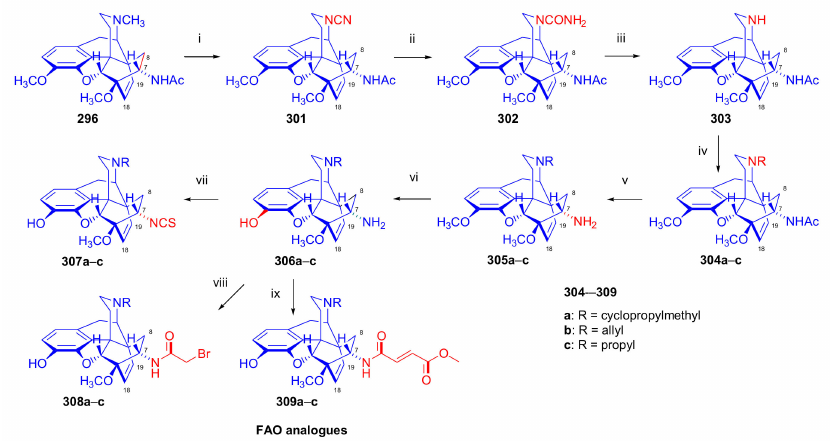
Figure 81. Synthesis of N 17 -substituted-7 α -acylamino-6,14-ethenomorphinan derivatives. Reagents and conditions : (i): BrCN, CHCl 3 , 16 h, reflux; (ii): 1M HCl, 90 ◦ C; (iii): NaNO 2 , 1M HCl, 4 h, 0 ◦ C; (iv): RBr, Na 2 CO 3 , EtOH, 16–30 h, reflux or NaHCO 3 , DMF, 85 ◦ C, 4 h; (v): 3M HCl, 110–115 ◦ C; (vi): BBr 3 , CHCl 3 ; (vii): 1.1 equiv. thiophosgene, NaHCO 3 , CHCl 3 , H 2 O, 20 min; (viii): bromoacetyl chloride, NaHCO 3 , CHCl 3 , H 2 O, 20 min; and (ix): methylfumaroyl chloride, NaHCO 3 , CHCl 3 , H 2 O, 20